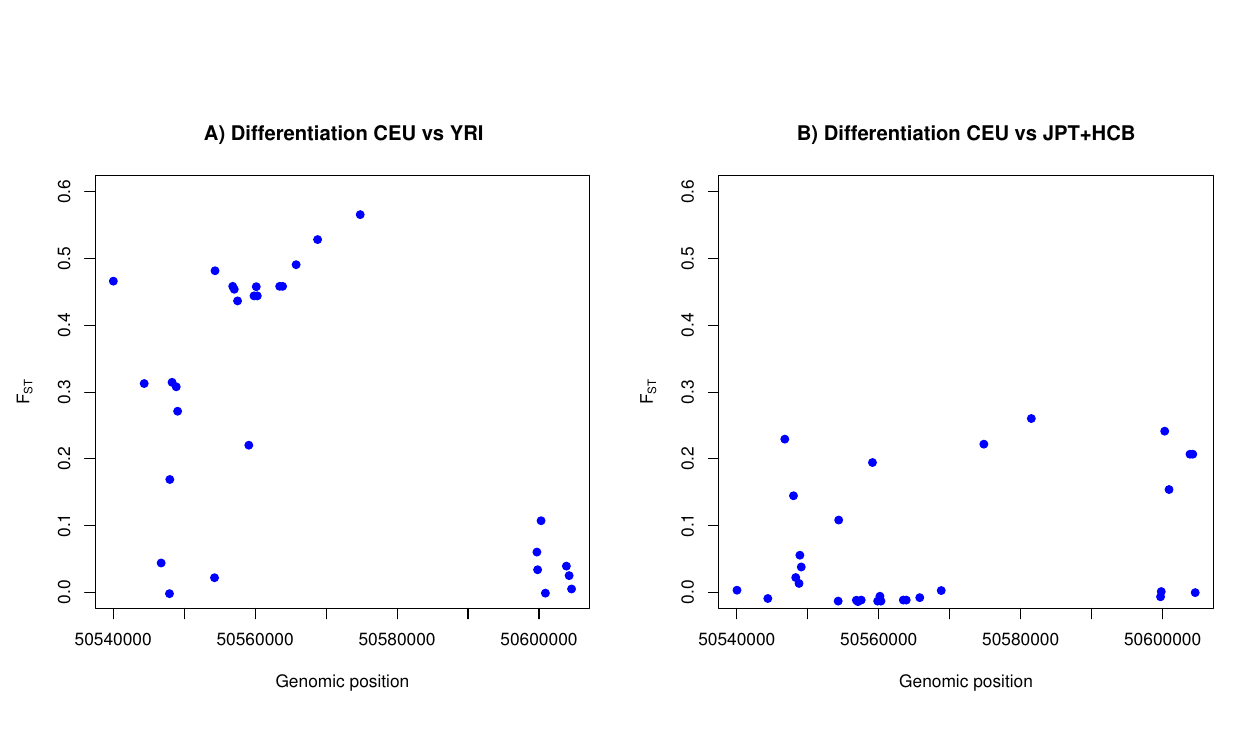
Figure 4 st F values in the region: A) between Africa and Europe, B) between Europe and Asia